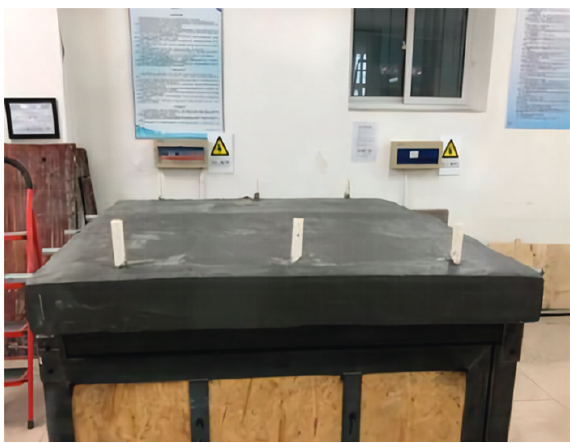
Figure 4: Scaled-down model of the anti-leakage system for reinforced concrete flat roofs.